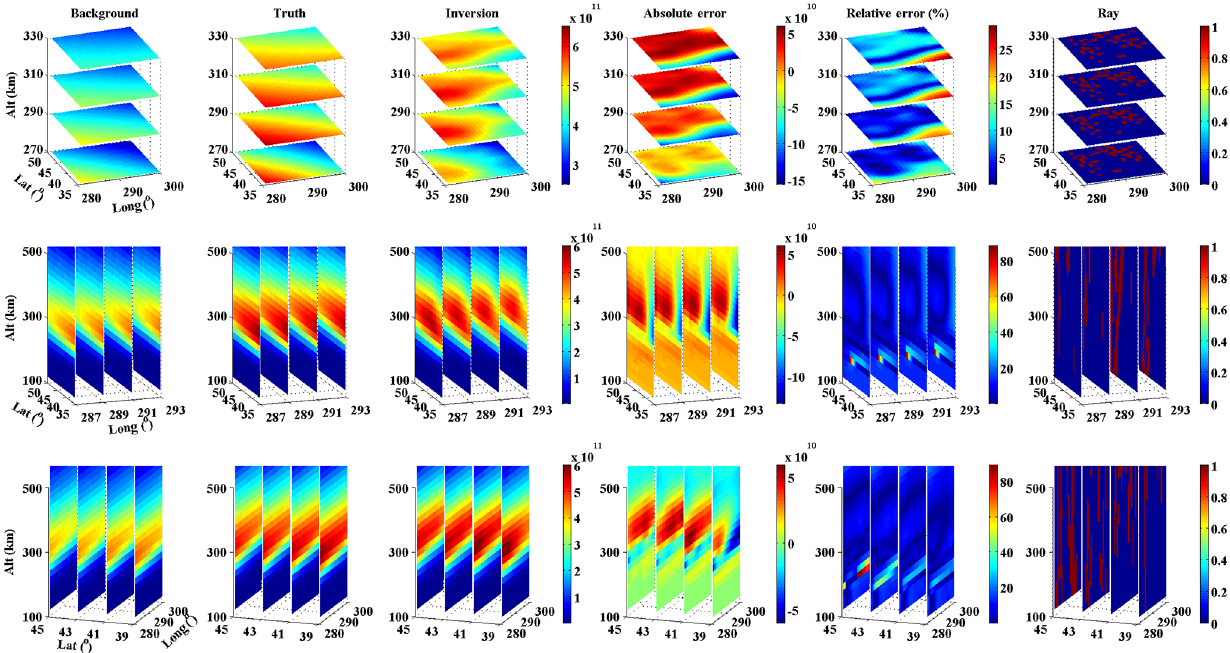
Figure 3. The reconstruction results using regularization method I under background I conditions. From top to bottom are the longitude– latitude slices at different altitudes, altitude–latitude slices at different longitudes, and longitude–altitude slices at different latitudes. From left to right are the background electron density, true electron density, reconstructed electron density, reconstructed absolute error, reconstructed relative error, and whether the satellite-receiver ray propagates through the corresponding grid or not.